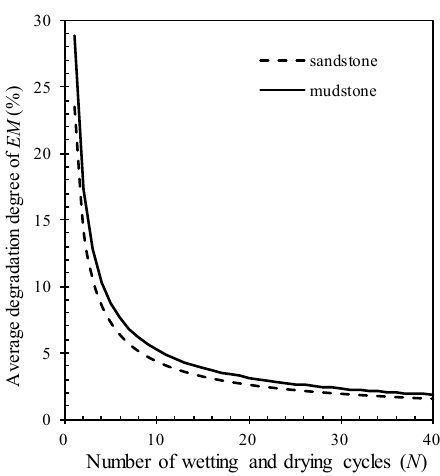
Figure 15. Fitted curves of average degradation degree of EM and wetting and drying cycles.